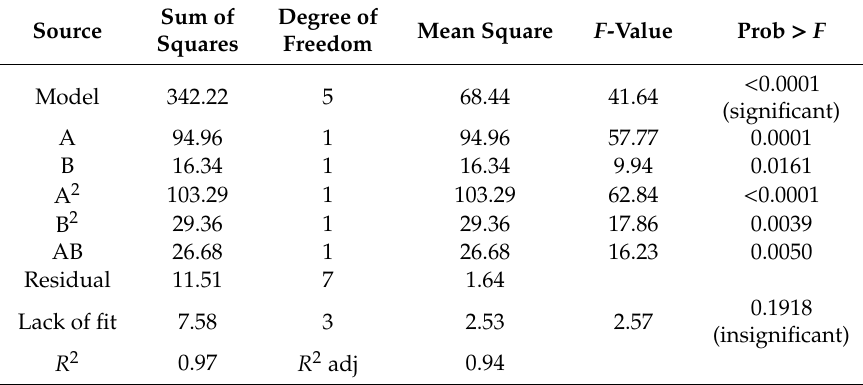
Table 3. ANOVA of the quadratic